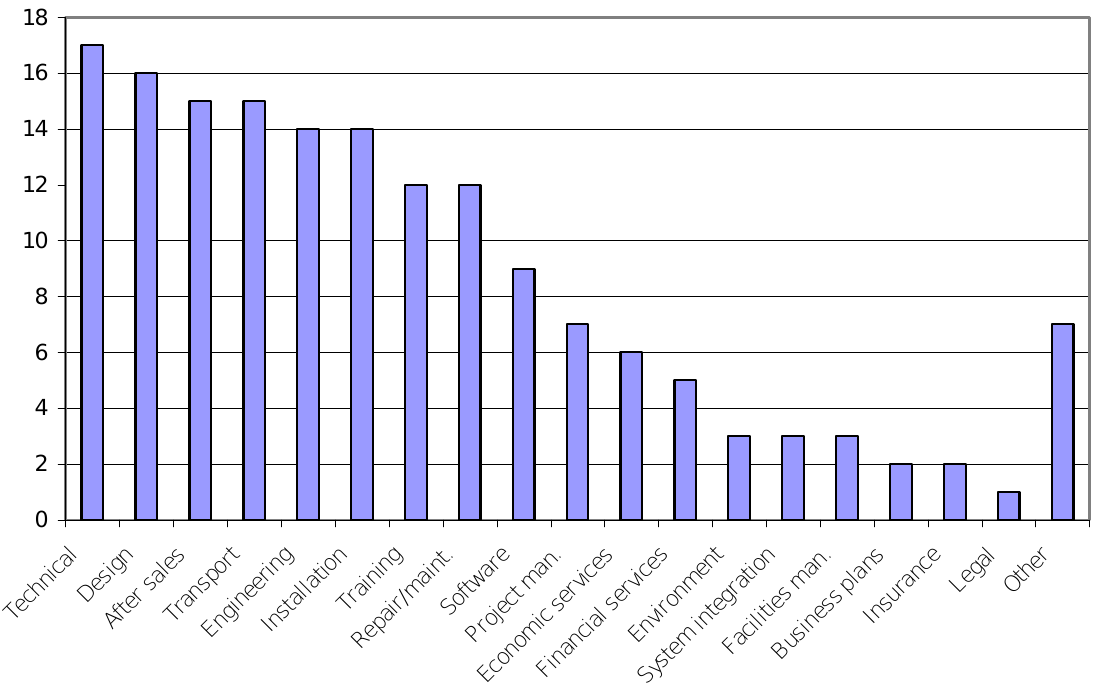
Figure 1: Nature of services provided to clients, by number of